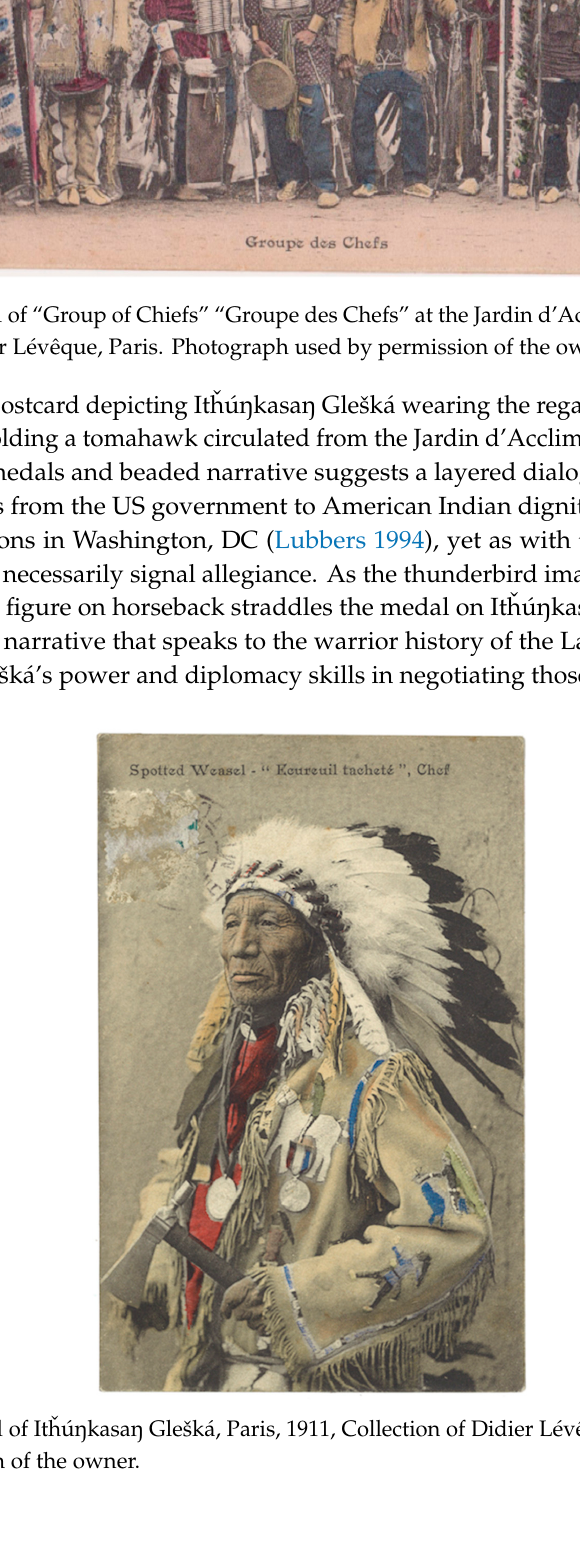
Figure 12. It ȟ ú ŋ kasa ŋ Glešká and Ȟ an ŋ té It ȟ ú ŋ kasa ŋ Glešká in London, 1909, photographic print, 29 cm × 24 cm, Denver Public Library, X-32146. Photograph used by permission of Denver Public Library.